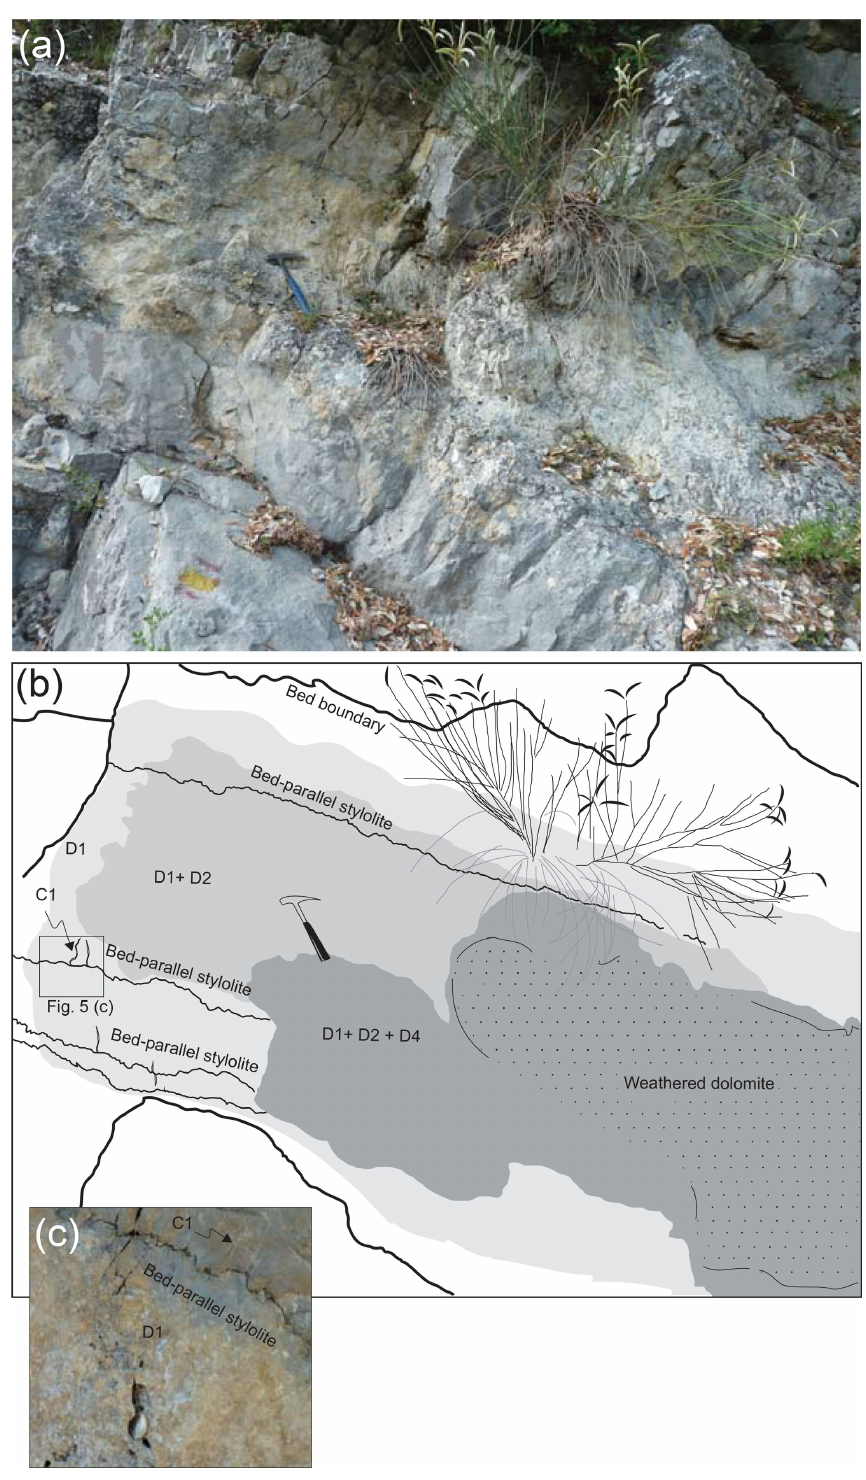
Figure 5. Field photograph (a) and a simplified sketch (b) of field site d showing a dolomitic pocket (grey color) and its relation with bed-parallel stylolites within the Calcare Massiccio Formation (hammer is 40cm long). Note C1 is the only calcite cement